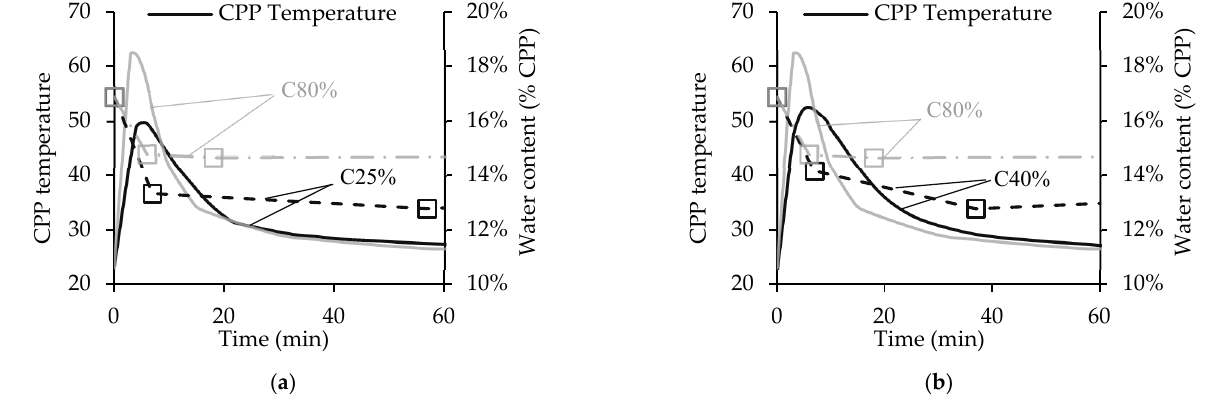
Figure 5. Water content and temperature for 25% and 40% CO 2 concentration. Comparison between C25% and C80% ( a ) and C40% and C80% ( b ).